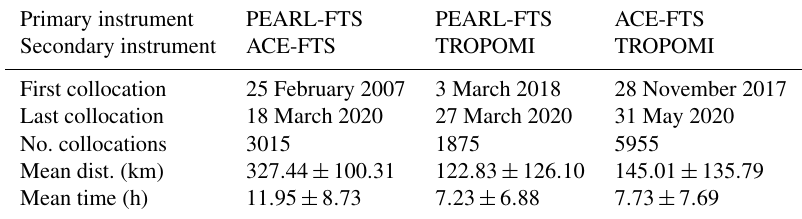
Table 2. Summary of the collocation statistics for each pair of instruments. Collocations between TROPOMI and ACE-FTS occur globally, while collocations involving the PEARL-FTS are limited to the region within a 500km radius from the Ridge Laboratory. The uncertainties provided for the mean distances and times are the standard